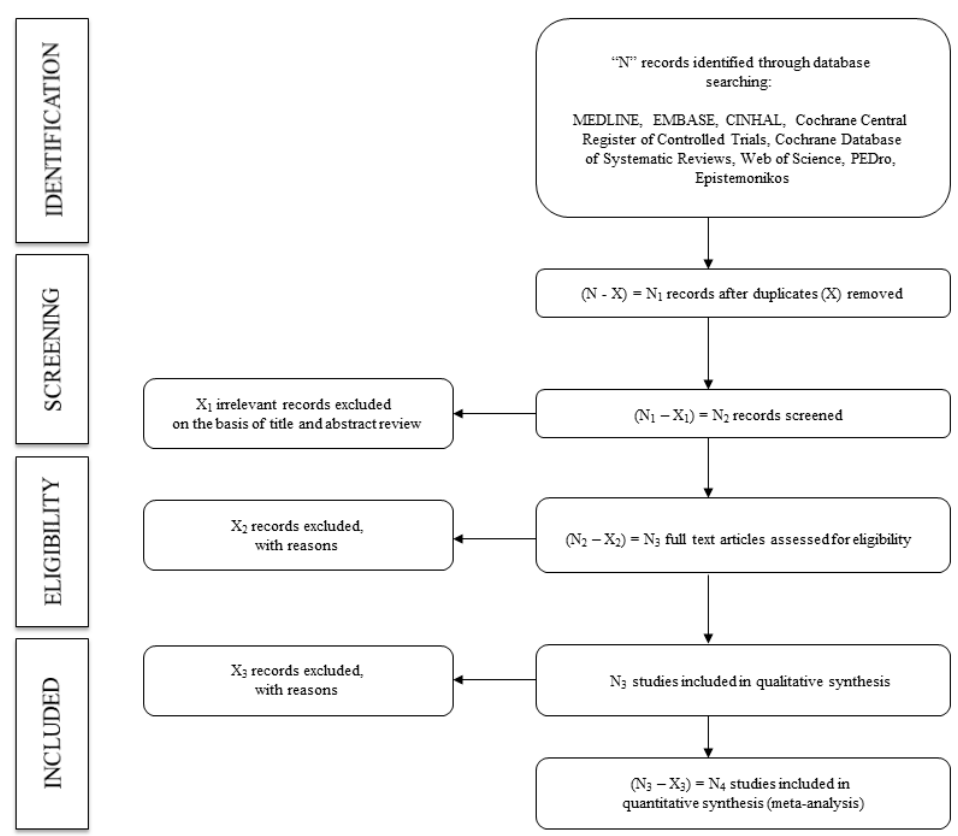
Figure 1. Flowchart of identification, screening, eligibility, and inclusion of studies.